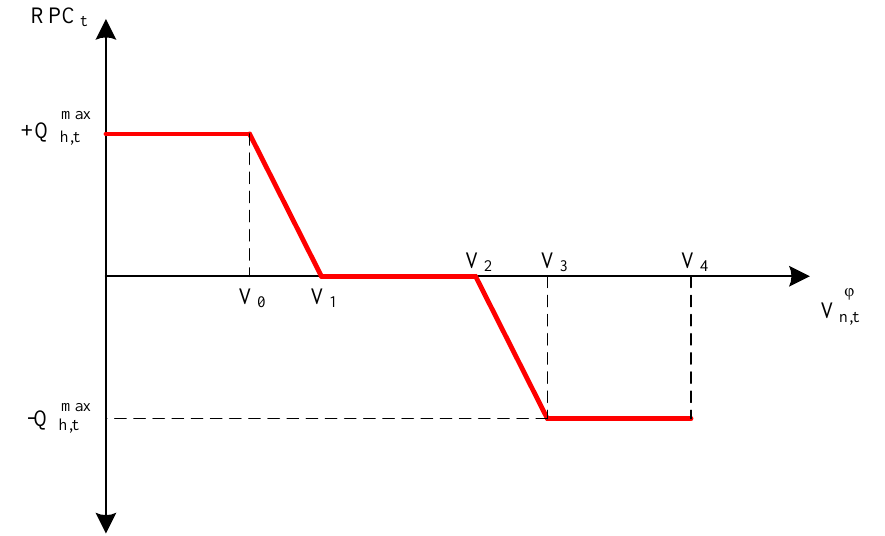
Figure 2. Reactive power compensation